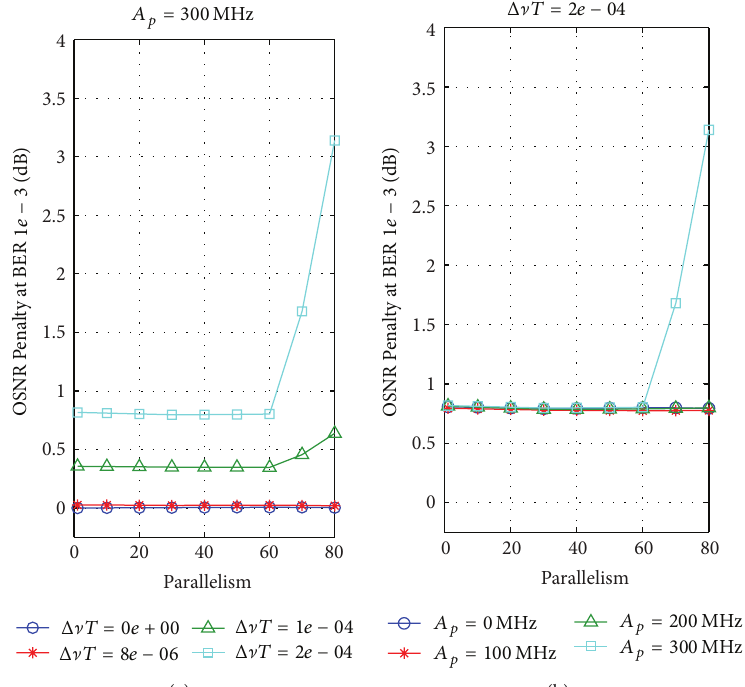
Figure 20: Two-stage CPR performance versus the parallelization factor. P-DPLL + BPS with Δ𝑓 𝑐 = 35 kHz, 1/𝑇 = 32 Gs/s, 𝑁 = 21 , and 𝐵 = 32 using 16-QAM scheme.